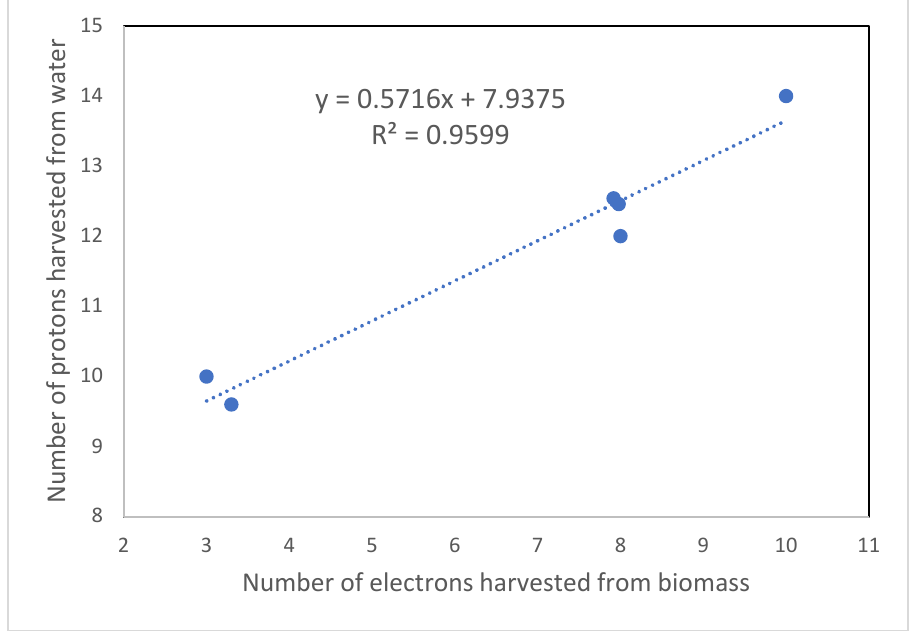
Figure 5. The linear equation between the number of protons from reacted water and the number of electrons harvested from biomass for a complete reactive lignocellulosic oxidation state.